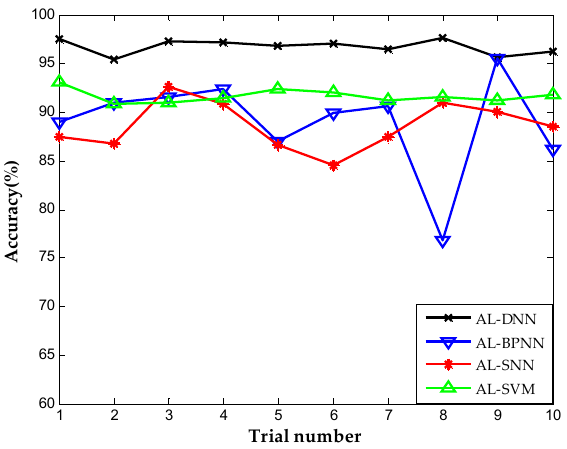
Figure 12. Correct diagnosis rate of AL-DNN, AL-BPNN, AL-SNN, AL-SVM on TE dataset.